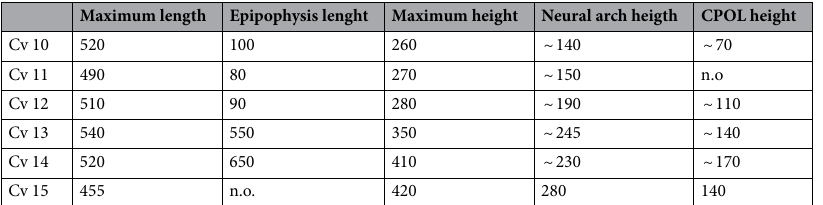
Table 1. Selected measurements of Silutitan sinensis gen. et sp. nov. (in mm). “ ~ ” indicates approximate measurements. n.o., not